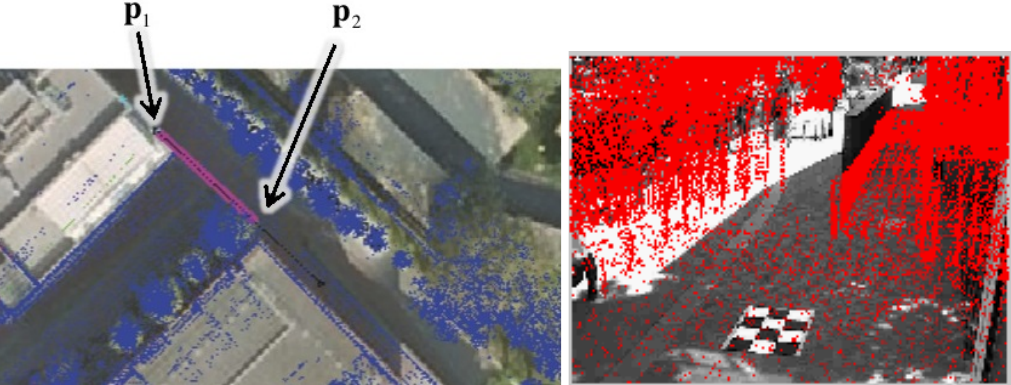
Figure 3. Graphical user interface. ( Left ) The point cloud is shown to the user overlaid on top of an aerial view of the environment. The user is prompted to select (1) a coarse camera location p ; and (2) the viewing direction p indicated by the magenta line; ( Right ) During 1 2 the initialization process, the user can manually adjust intrinsic and extrinsic parameters on a projected view of the point